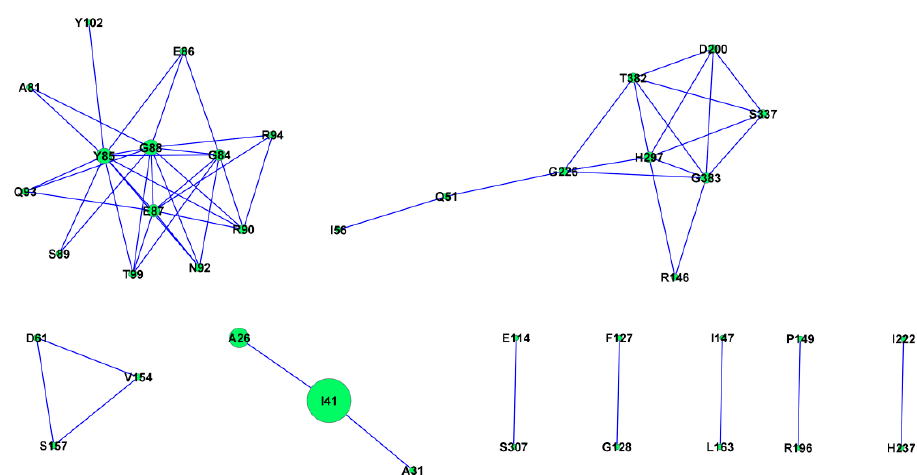
Figure 4. Larger nodes correspond to greater numbers of connected sites. 387